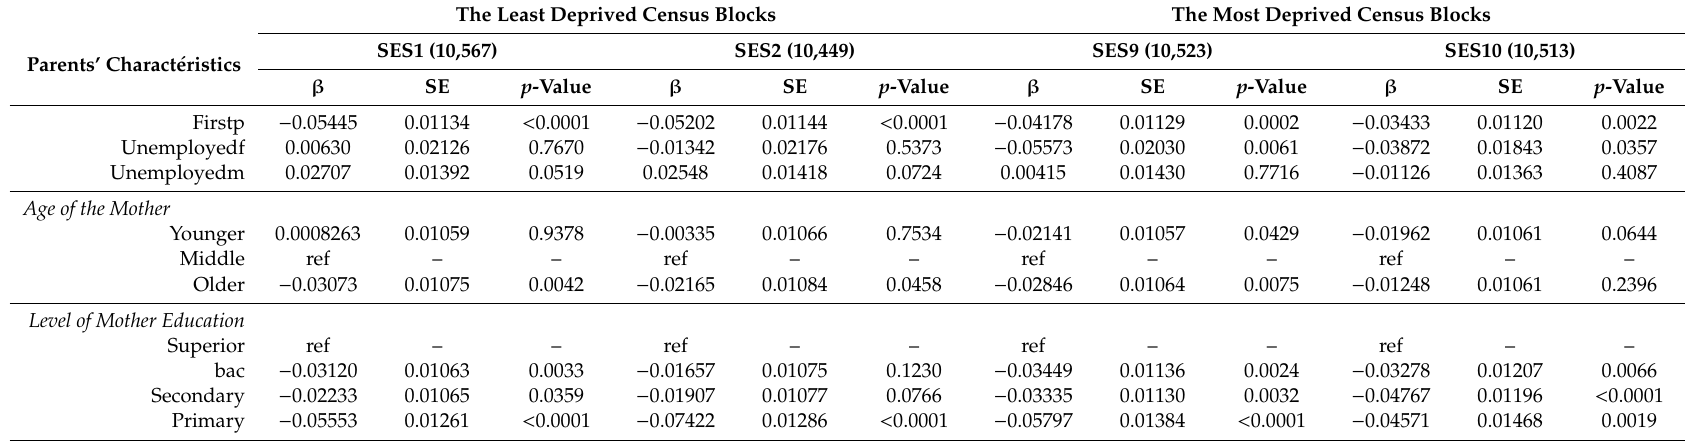
Table 4. MLR estimates of the direct e ff ects of parents’ characteristics on Favorable Fetal Growth Conditions (FFGC) from Model 3 stratified by neighborhood deprivation index (as described in the Figure